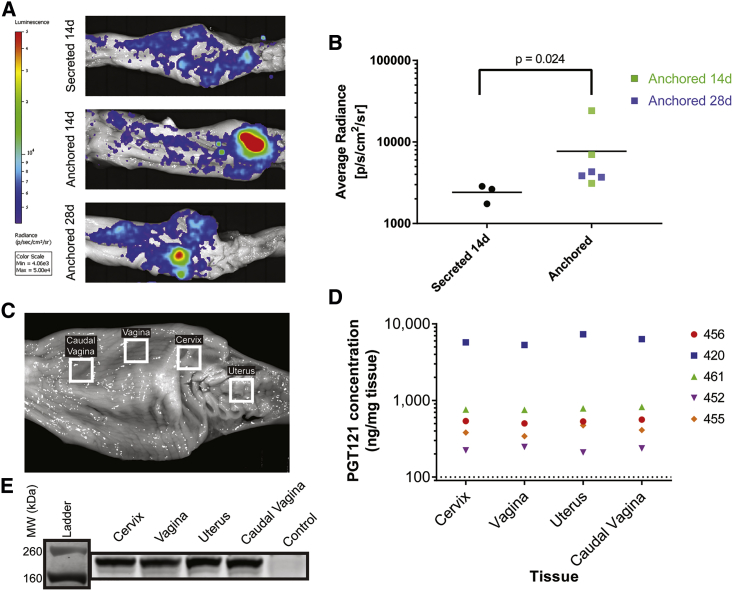
aPGT121 Persists in the FRT Mucosa at 28 Days Post-transfection(A) IVIS imaging of the excised lower FRT at 14 days and 28 days post-transfection. 28-day samples for sPGT121 transfected animals were not collected due to the low signal observed at 14 days. (B) Average radiance of the secreted and anchored PGT121-NanoLuc constructs. Mann-Whitney non-parametric analysis was used to compare the two groups (C) After 28 days, tissue samples were excised under the guidance of IVIS signal, snap-frozen, and pulverized for downstream western blot analysis. (D) Day 28 post-transfection aPGT121 concentrations in excised cervix, vagina, uterus, and caudal vagina were estimated using quantitative western blot. Five animals, euthanized at 28 days, were used in total. (E) Western blot demonstrating the characteristic aPGT121 band at 195 kDa for all regions of the FRT of one treated sheep, compared to control cervix.